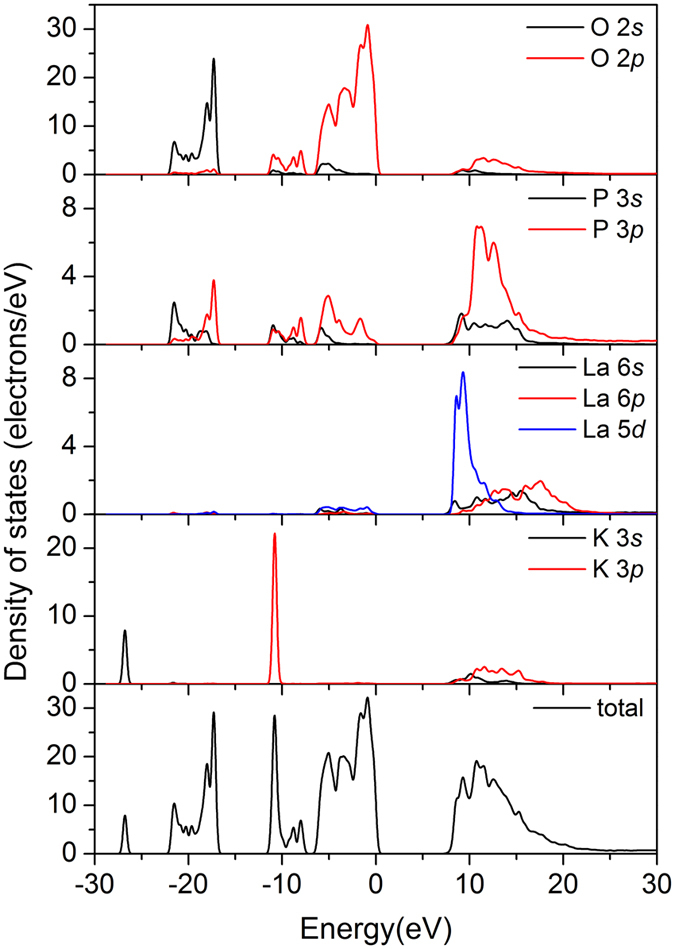
The total and partial densities of states of KLa(PO3)4.